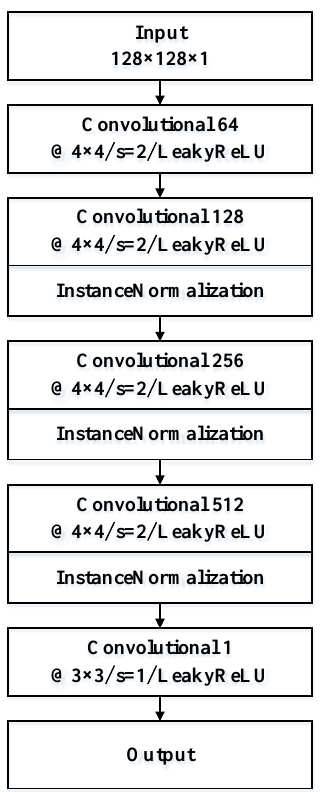
Figure 4. Structure of the discrimination model.